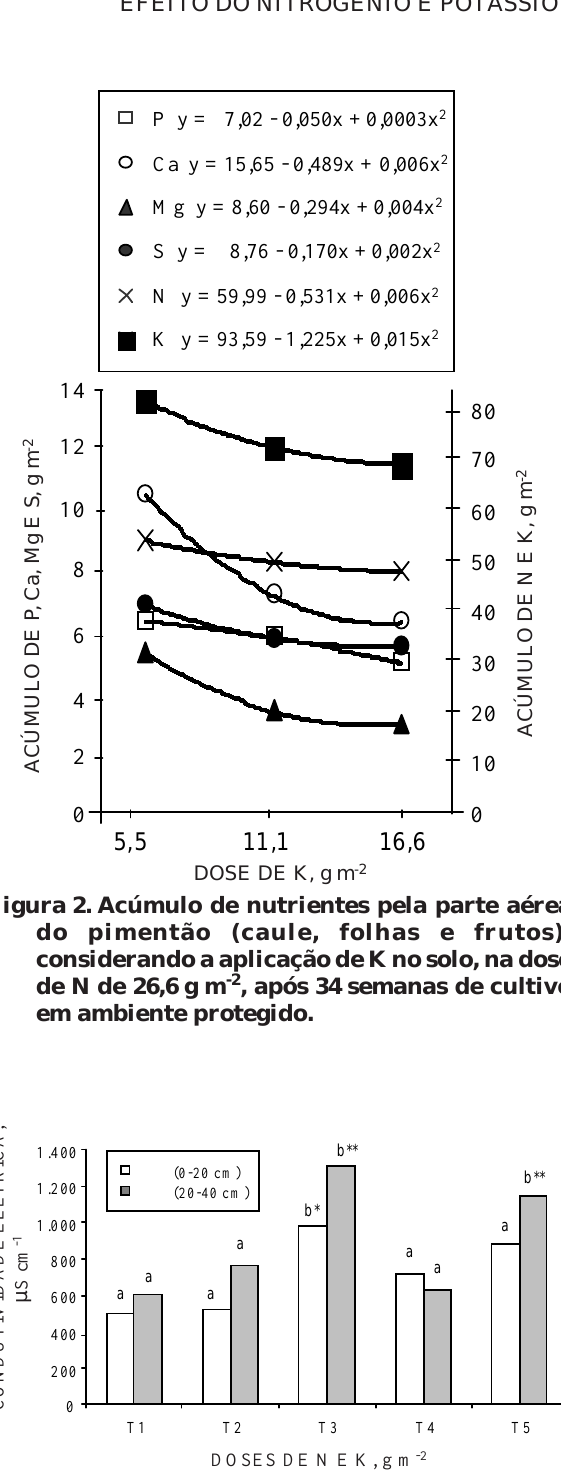
Figura 3. Condutividade elétrica do solo cultivado com pimentão, após 34 semanas, considerando a profundidade de amostragem e as doses de N e K aplicados ao solo. Para a mesma profundida- de, barras seguidas da mesma letra não diferem significativamente pelo teste de Dunnett a 5 (*) e 1 (**)%. T1- testemunha sem N e K; T2- N = 13,3 e K = 5,5 g m -2 ; T3 - N = 13,3 e K = 16,6 g m -2 ; T4 - N = 39,9 e K = 5,5 g m -2 ; T5 – N = 39,9 e K = 16,6 g m -2